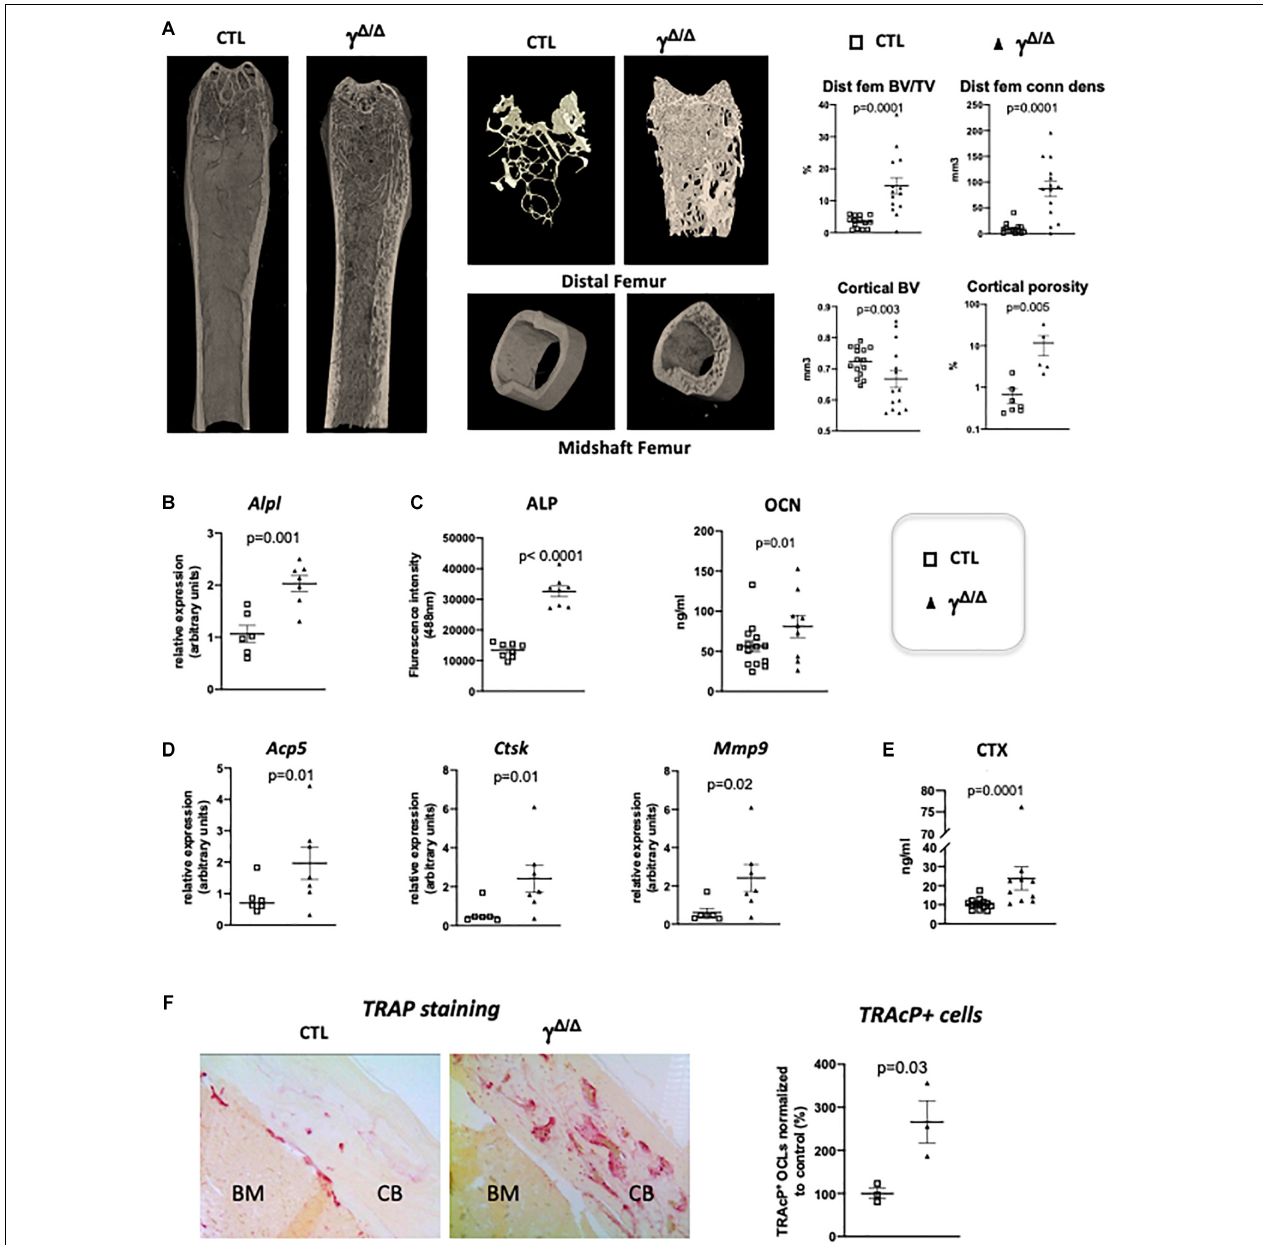
FIGURE 1 | Epiblastic PPAR γ -deletion induces trabecular and cortical bone alteration. (A) Micro-CT analysis of femur from Pparg (cid:49)/(cid:49) ( γ (cid:49)/(cid:49) ) one-year old female mice or control female littermates (CTL). Dot plots on the right show for the different genotypes (empty square for CTL and black triangle for γ (cid:49)/(cid:49) ) the percentage bone volume/trabecular volume (BV/TV) in % and connectivity density (ConnDens) of distal femoral trabecular bone (upper panels), and the cortical bone volume (BV) in mm 3 and the percentage of cortical porosity of femur (lower panels). All mice were 1-year-old. (B) RT-qPCR analysis of Alkaline phosphatase ( AlpI ) gene expression in femur from CTL and γ (cid:49)/(cid:49) . (C) ELISA measurements of serum Alkaline phosphatase (ALP) and osteocalcin (OCN). (D) RT-qPCR analysis of Acid Phosphatase 5-Tartrate Resistant ( Acp5 ), Cathepsin K ( Ctsk ), and Matrix Metallopeptidase 9 ( Mmp9) expression in femur from CTL and γ (cid:49)/(cid:49) . (E) ELISA measurements of serum Carboxy-terminal Collagen I telopeptide (CTX). (F) Representative images of TRAcP staining of decalcified sections of femurs, at mid-shaft levels, from control (CTL) or Pparg (cid:49)/(cid:49) ( γ (cid:49)/(cid:49) ) mice. CB, cortical bone; BM, bone marrow. Data are presented as mean ± S.E.M. Each dot represents an individual animal. Statistical significance was determined by two-tailed unpaired t